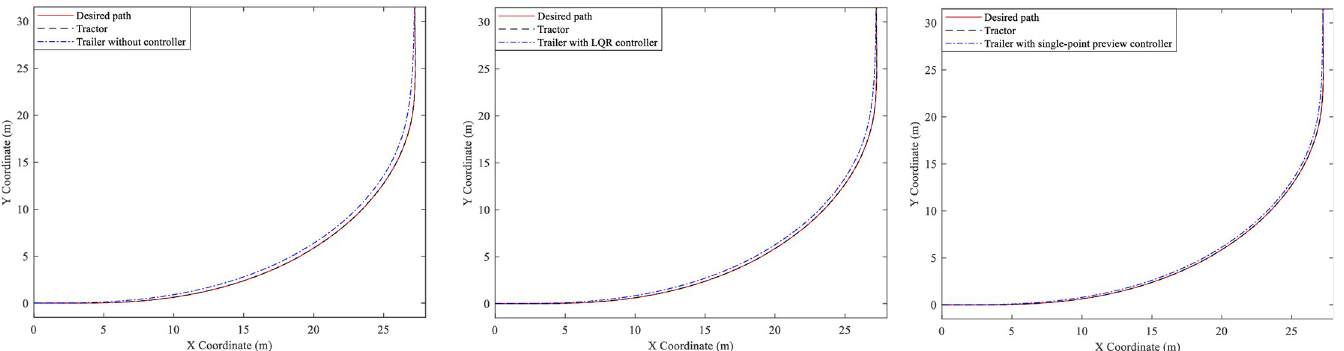
Fig 10. Trajectory curves. (A) Trailer without controller. (B) Trailer with LQR controller. (C) Trailer with single-point preview controller.